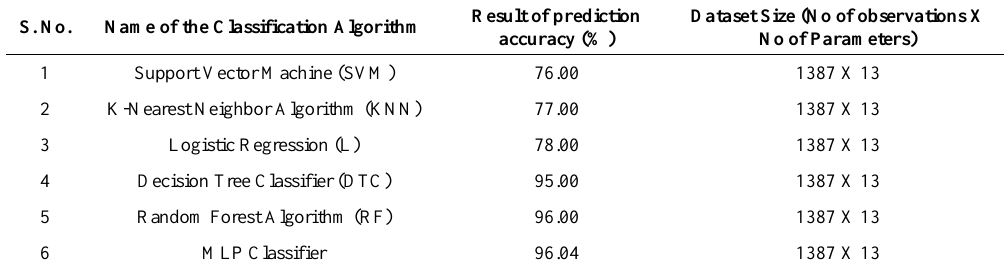
Table 3. Comparison study of various classification algorithms over the dataset including MLP classifier.